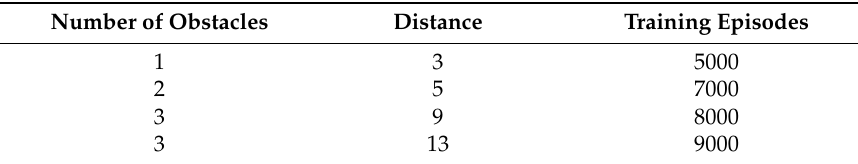
Table 2. Learning plan of modified curriculum learning.